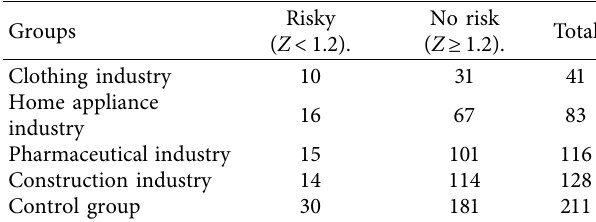
Table 10: Sample data classifcation.